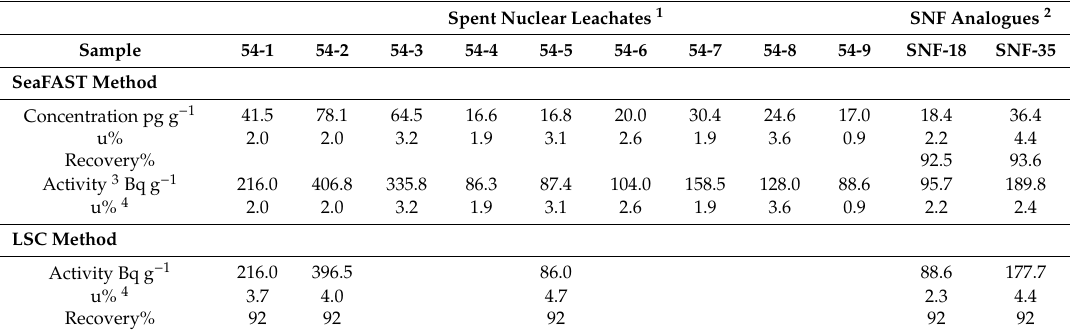
Table 2. Main results on the determination of 90 Sr in diluted spent fuel leachates using the SeaFAST system with ICP-DRC-MS detection and Liquid Scintillation